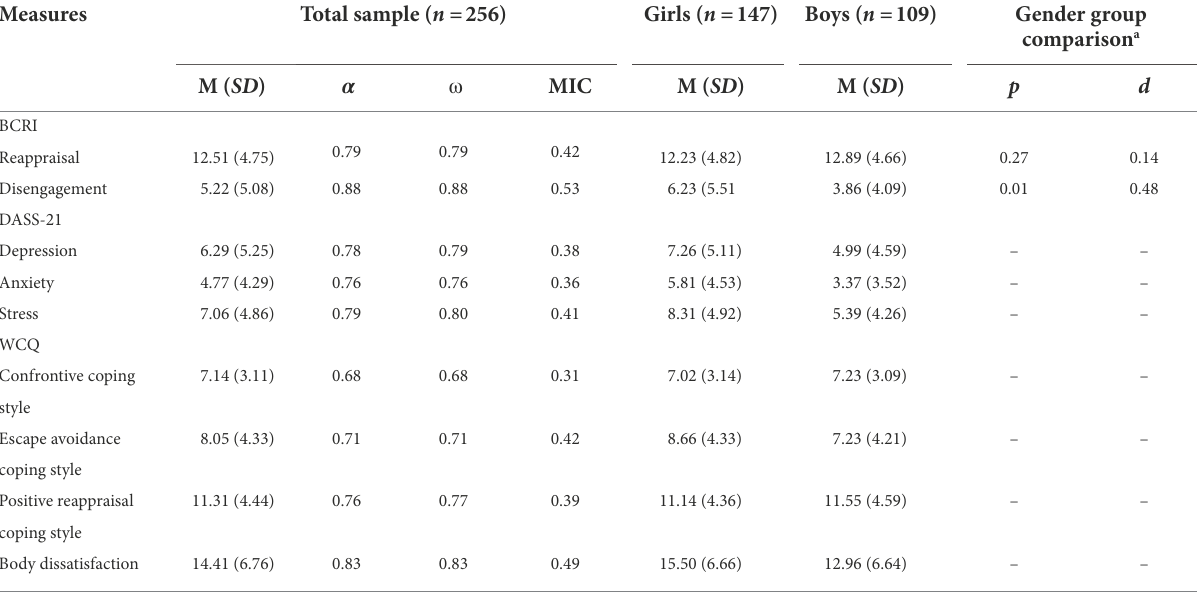
Table 3 Mean, standard deviation, and internal consistency of the BCRI in the total sample and in subsamples of boys and girls separately.